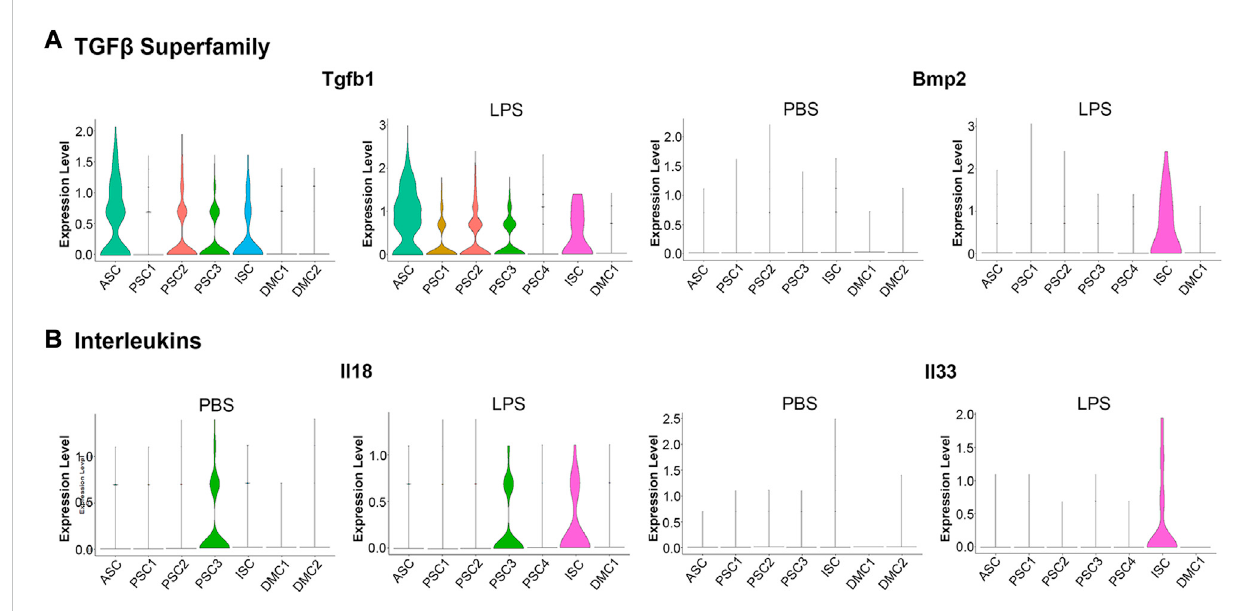
FIGURE 6 Violin plots ofcytokine transcription inPBSandLPStreatedMuSCs. (A) Thetranscription patternoftheTGF β superfamilygenes Tgfb1 and Bmp2 . (B) The transcription pattern of the Interleukins superfamily genes Il18 and Il33 . Expression is depicted as Log 2 FC above average expression across all